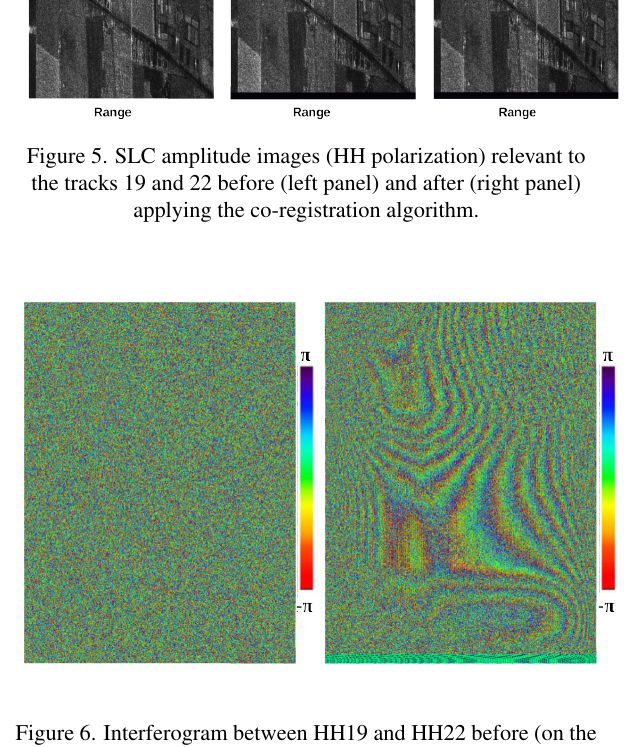
Figure 6. Interferogram between HH19 and HH22 before (on the left) and after (on the right) applying the co-registration step.